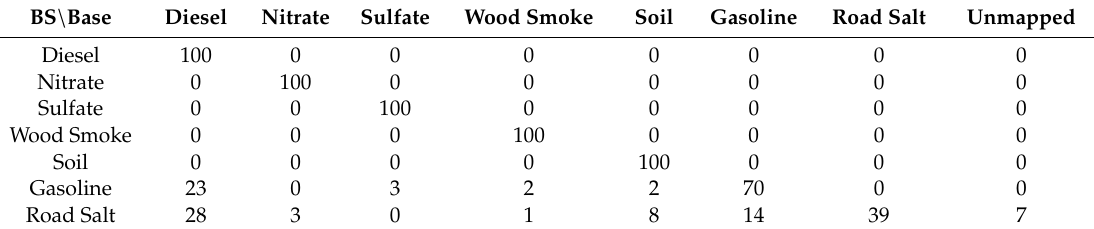
Table A3. Bootstrap mapping results. (BS—bootstrap; base—base